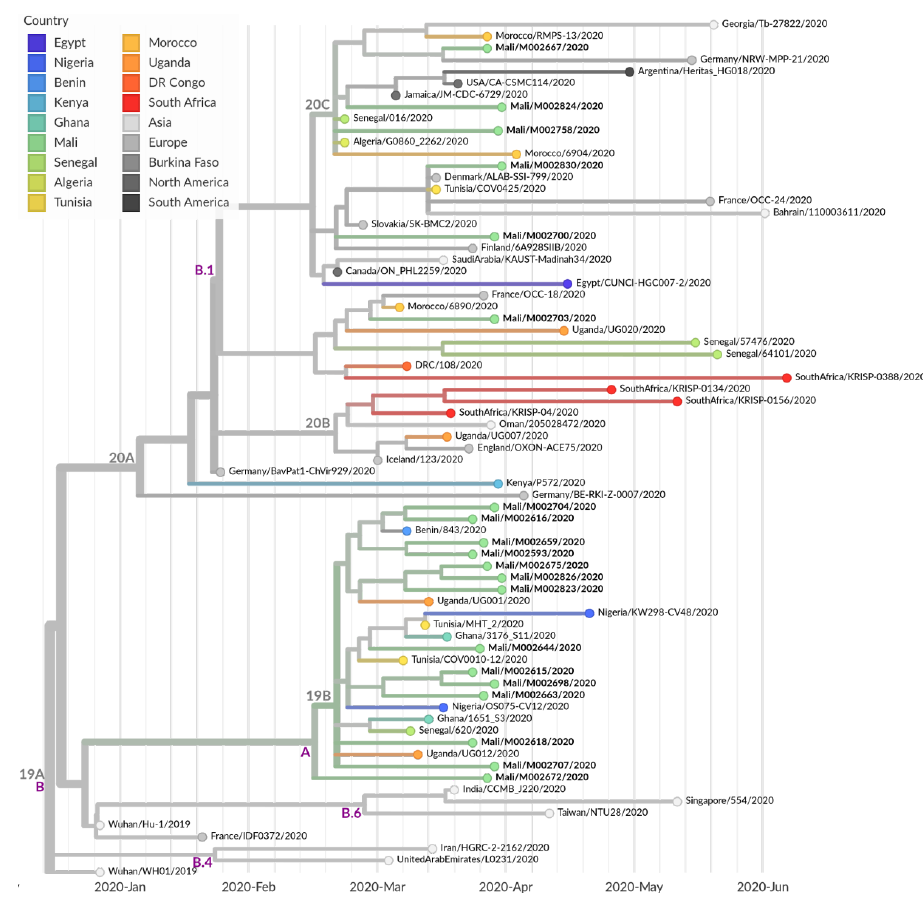
Figure 4. Maximum likelihood cladogram based on 47 representative genomes of African samples as, well as 26 genetic, closely related samples from Asia, Europe and North and South America. Nextstrain.org clade nomenclature is shown in gray and above branch nodes. Pangolin clade nomenclature is shown in violet and below branch